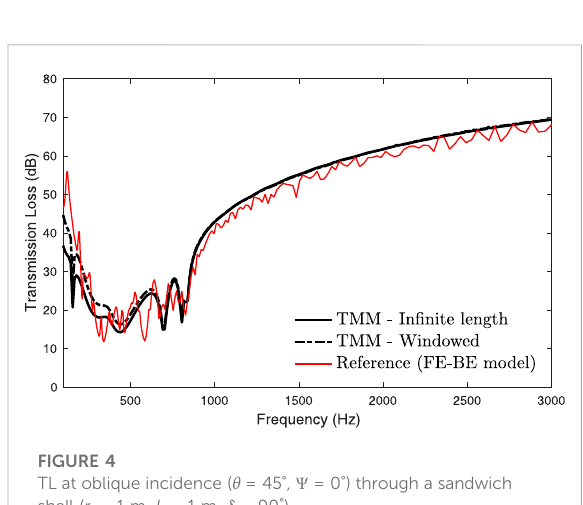
FIGURE 3 TL at oblique incidence ( θ = 45 ° , Ψ = 0 ° )through a2 mm thick steel shell ( R = 1 m, L = 0.5 m, δ = 90 ° ).